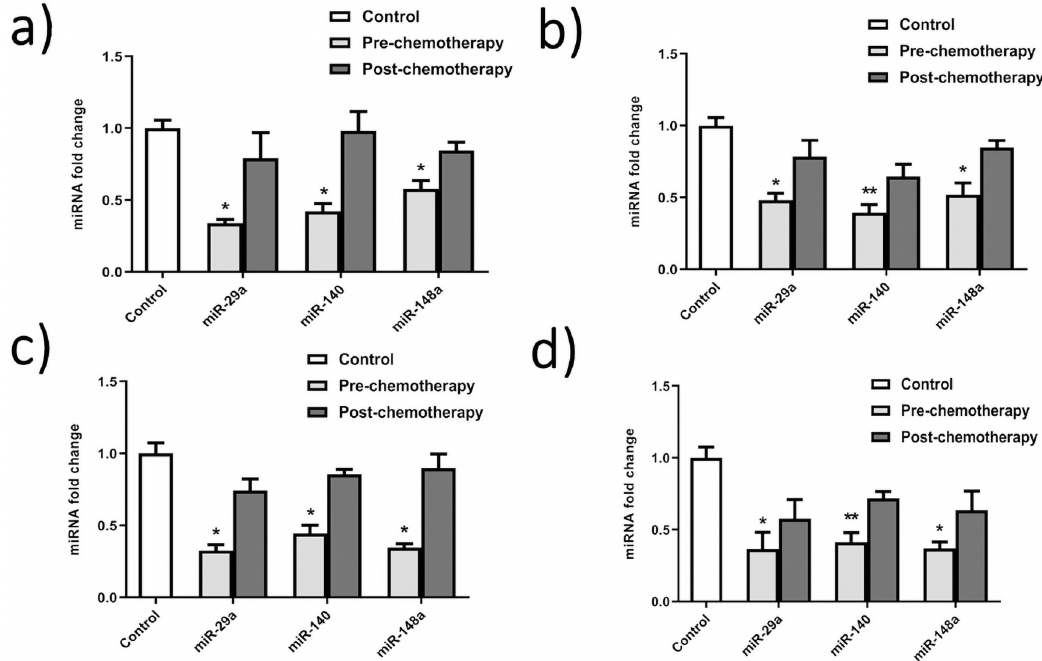
Fig 5. miRNA expression analysis in breast cancer patients’ samples. a) G-II blood samples b) G-II biopsy samples c) G-III blood samples d) G-III biopsy samples. The qRTPCR results show differential expression patterns of miR-29a, miR-140, miR148 in G-II and GIII breast cancer clinical samples. All the reactions were carried in triplicates. Error bars show ± SD. ANOVA test applied to the data at � P < 0.05, �� P < 0.001.